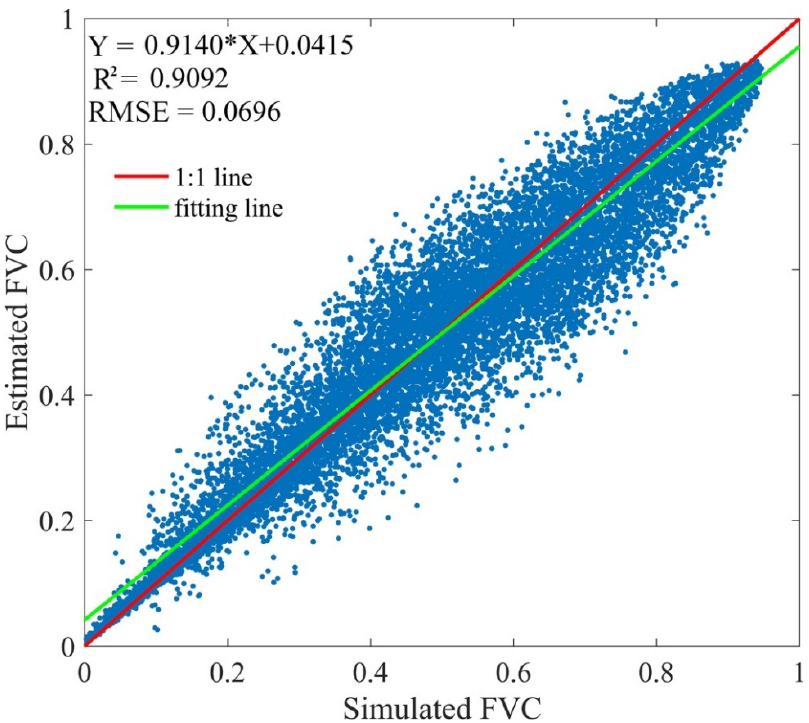
Figure 4. Theoretical performance of the random forest regression using simulated FVC data.